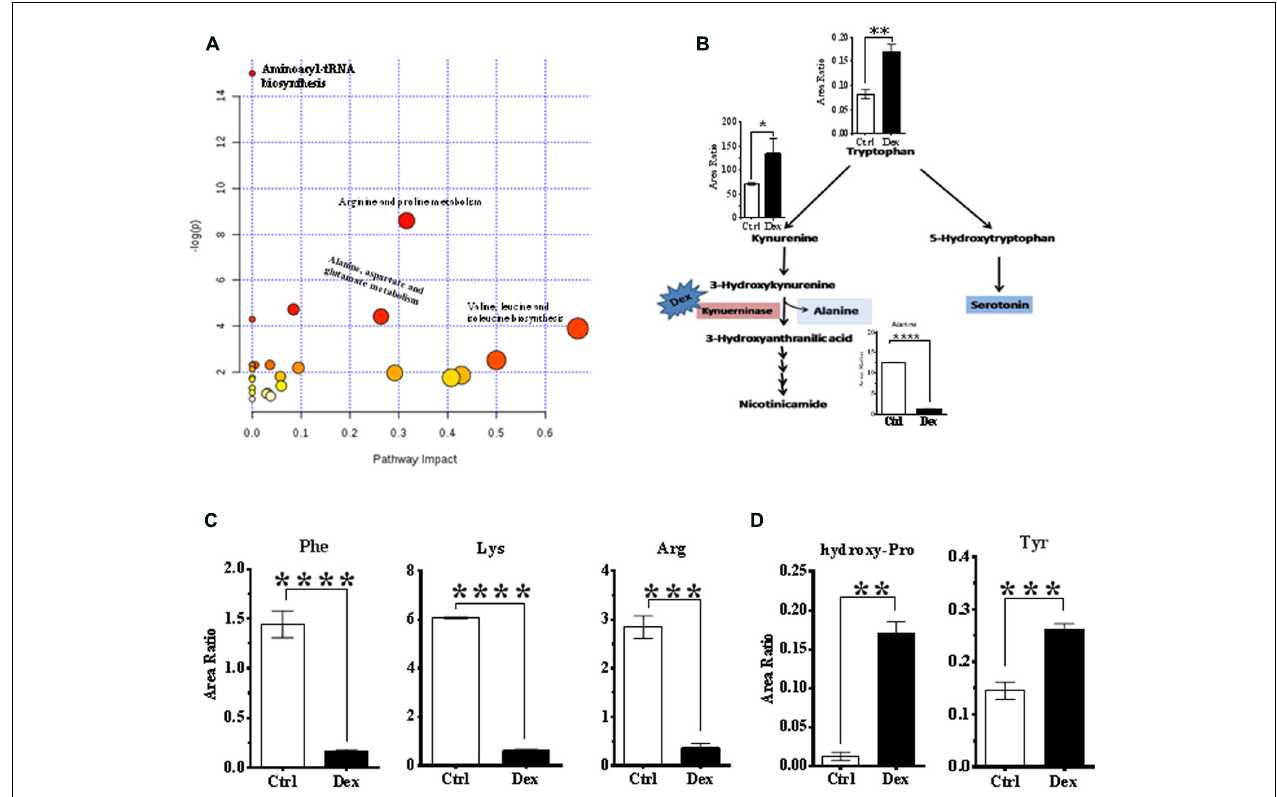
FIGURE 4 | Analysis of metabolic pathways. (A) Summary of pathway analysis for the most relevant pathways involved under experiment conditions. (B) Tryptophan-kynurenine metabolism pathway. Dexamthesaone inhibits kenureninase which causes accumulation of kynurenine, 3-hydroxy-kenurenine, tryptophan and secondarily serotonin (5-hydroxytryptamine). Dex treatment causes significant elevation in serum levels of tyrosine (C) and hydroxyproline (D) and significant reduction in phenylalanine, lysine and